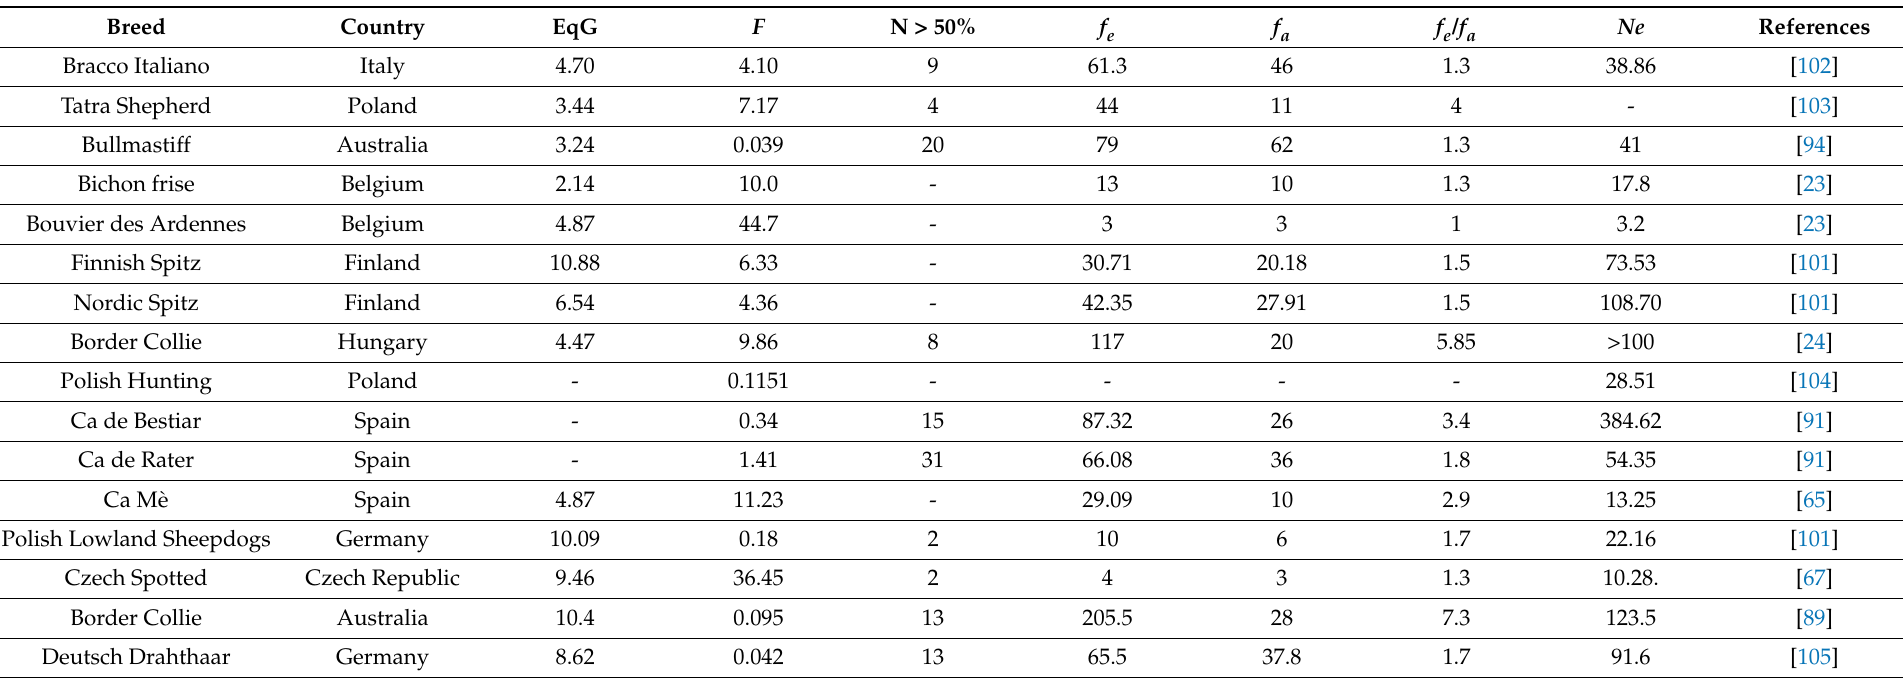
Table 1. Genetic diversity of dog breeds assessed using pedigree